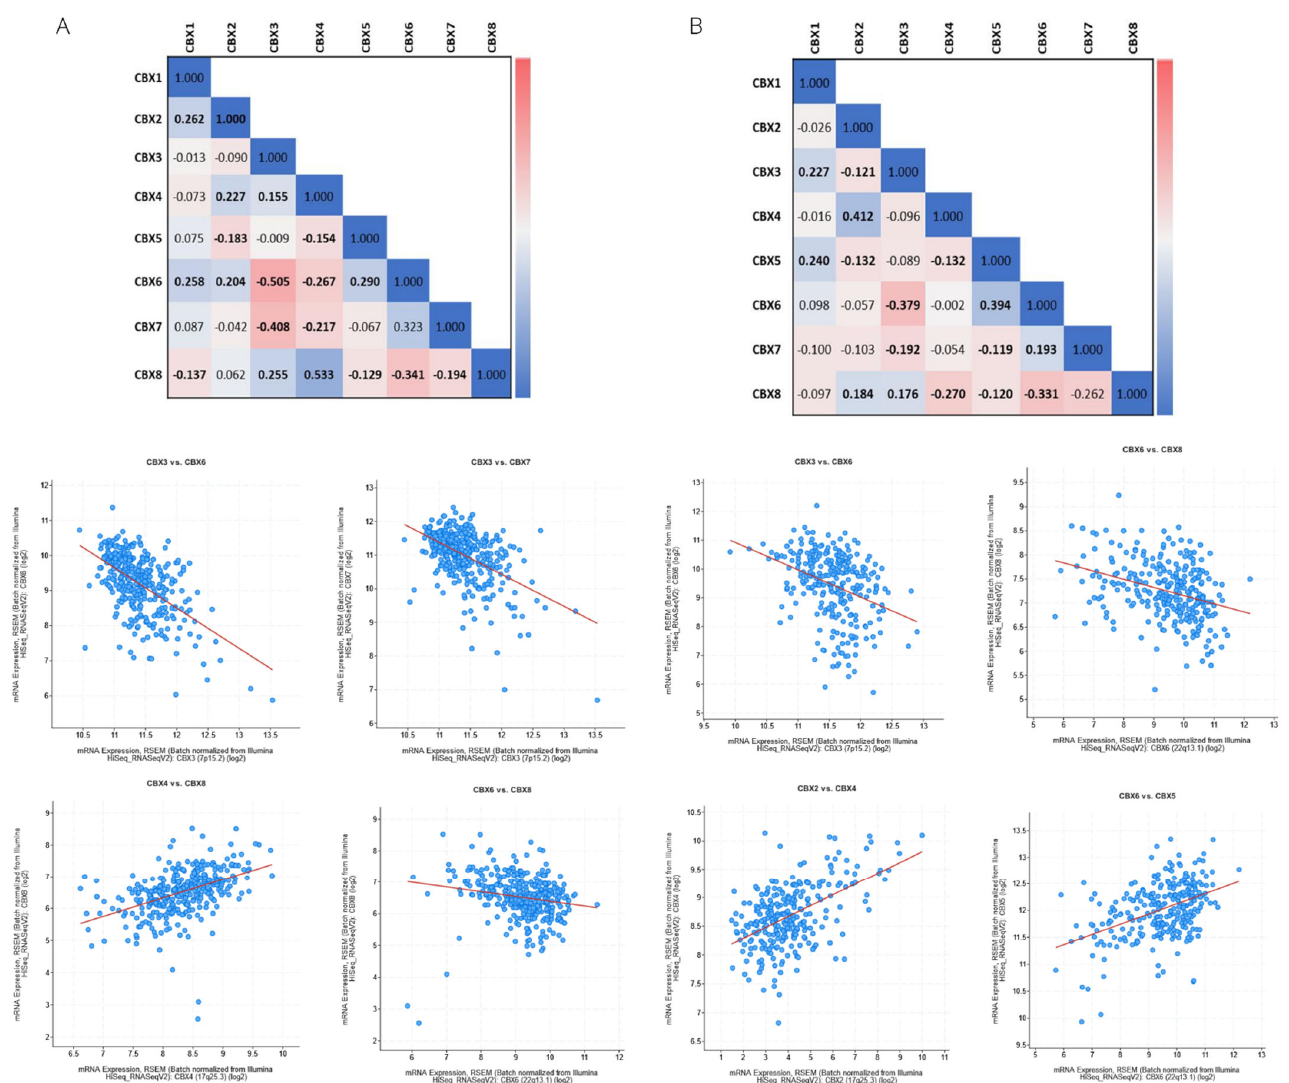
Figure 6. Correlations for mRNA expression of pairwise combinations of CBX family members in ccRCC ( A ) and pRCC ( B ) subtypes. Tables include Spearman’s Correlation coefficient (the bold font denotes p value < 0.05). The color scale interprets the correlation coefficient value. Plots show significant correlations (Spearman’s correlation coefficient >0.3 and p < 0.05).